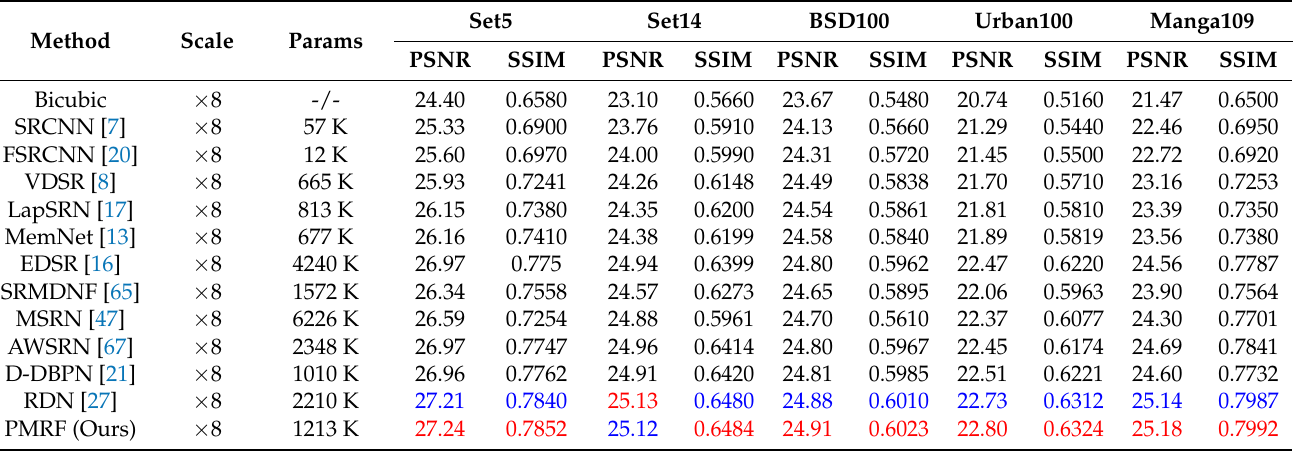
Table 10. Quantitative benchmark test results at × 8 scale. Red indicates the best performance and blue indicates the second best.